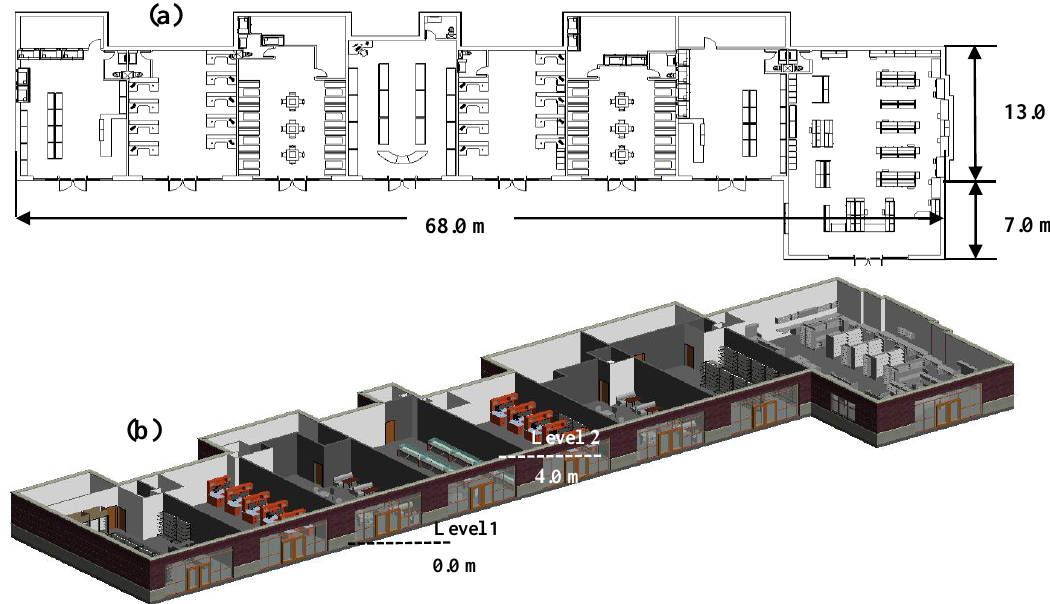
Figure A7. F7 archetype plans and views: ( a ) Plan view; ( b ) 3-D view.